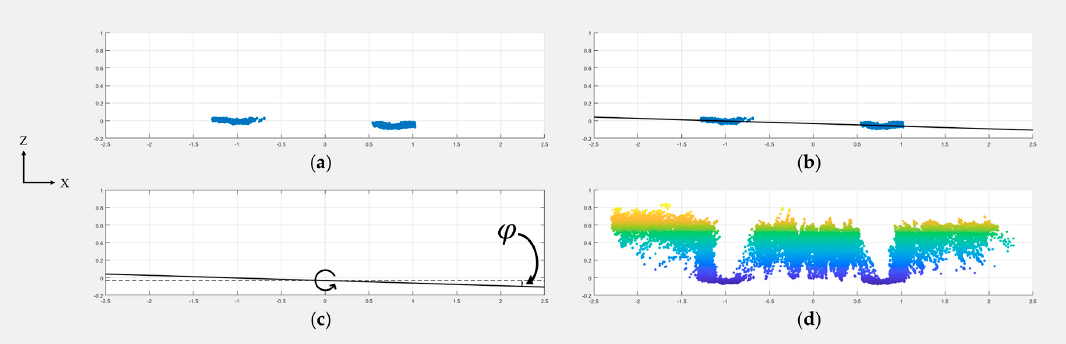
Figure A4. An example of X-Z plane rotation correction: ( a ) point cloud of ground before rotation; ( b ) linear curve fitted to ground points on the X-Z plane; ( c ) rotation of points on the X-Z plane by the angle φ ; ( d ) point cloud after rotation.